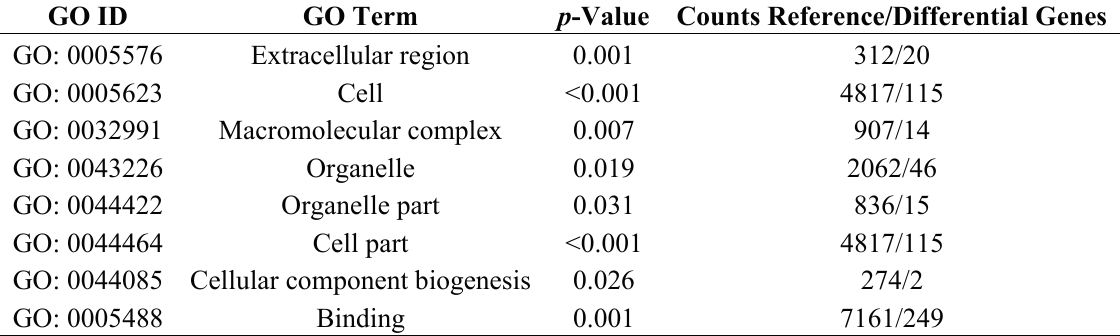
Table 3. The gene ontology (GO) enrichment results of genes with significantly different expression in SM and FW samples.